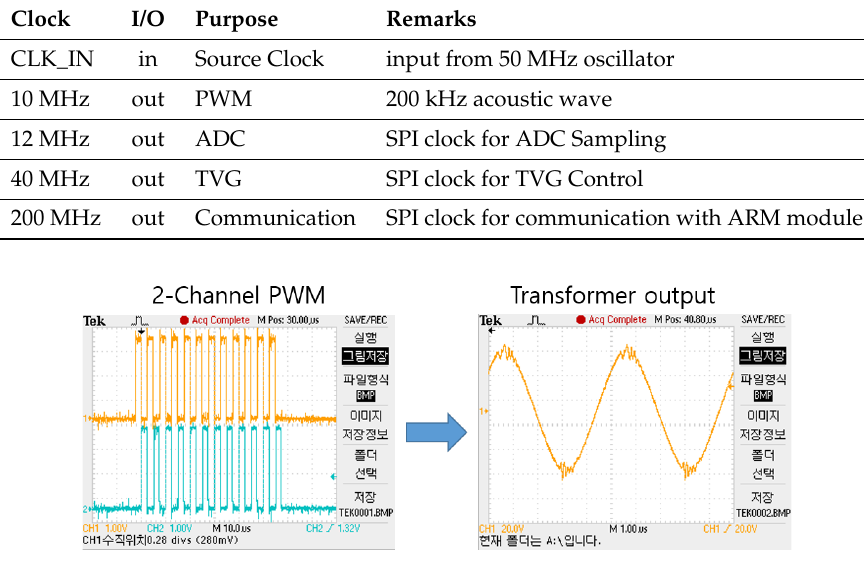
Figure 9. 200 kHz acoustic signal generation in